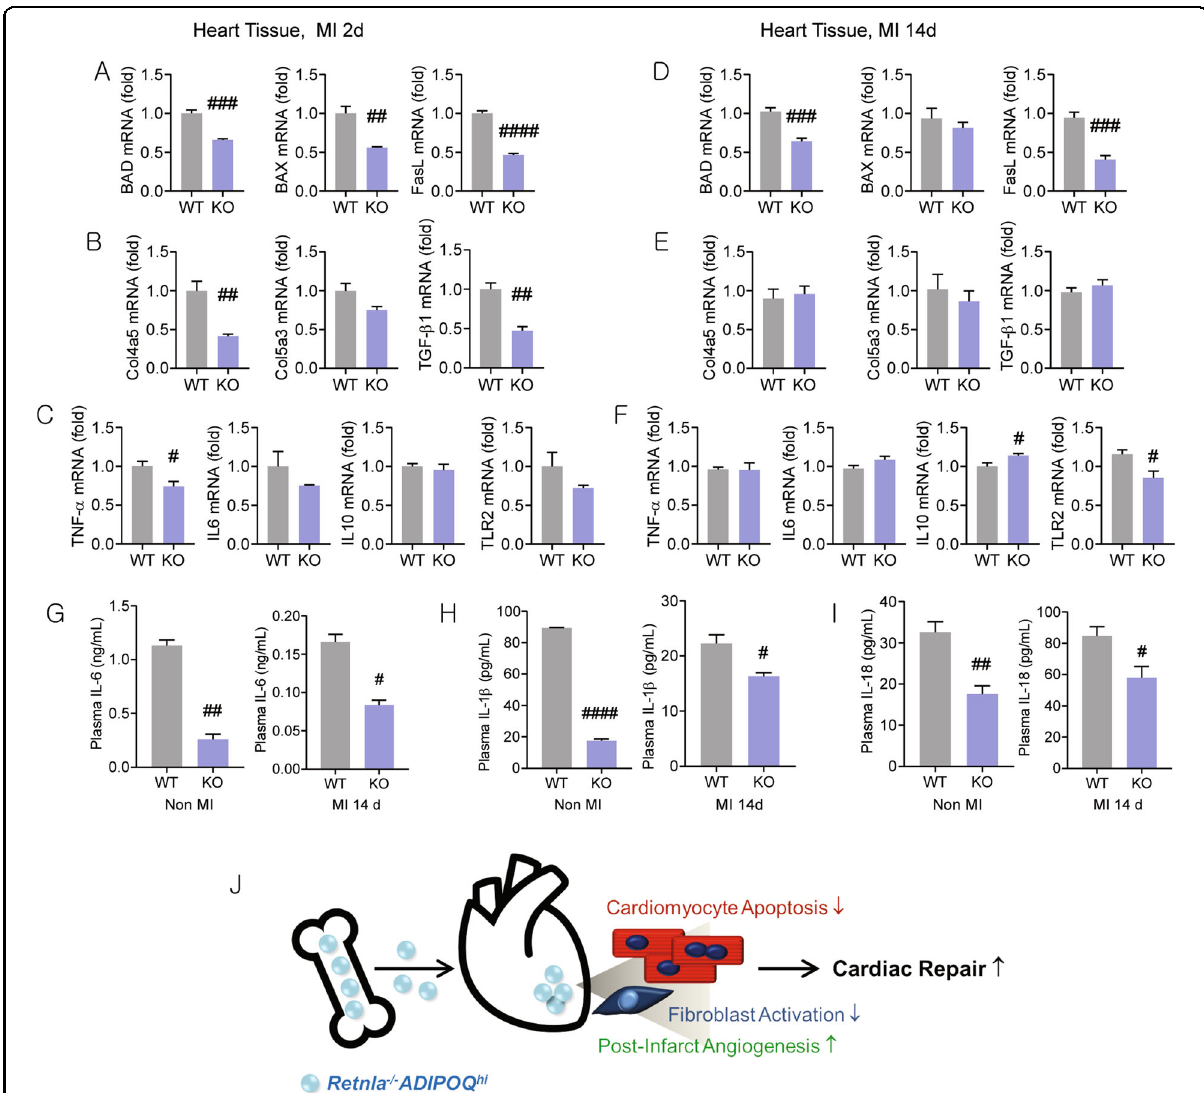
Fig. 5 Expressional changes of signaling molecules of apoptosis, in fl ammation, fi brosis, and tissue repair in the heart tissues. Heart tissues were collected at day 2 ( A – C ) and 14 ( D – F ) after MI to analyzed signaling molecules. BCL2-associated agonist of cell death (BAD), BCL2-associated X, apoptosis regulator (BAX), and Fas ligand (FasL) are cell death-related molecules. Collagen type IV, α 5 (Col4 α 5), collagen type V, α 3 (Col5 α 3), and transforming growth factor- β 1 (TGF- β 1) are fi brosis-related molecules. Tumor necrosis factor- α (TNF- α ), interleukin-6 (IL-6), IL-10, and toll-like